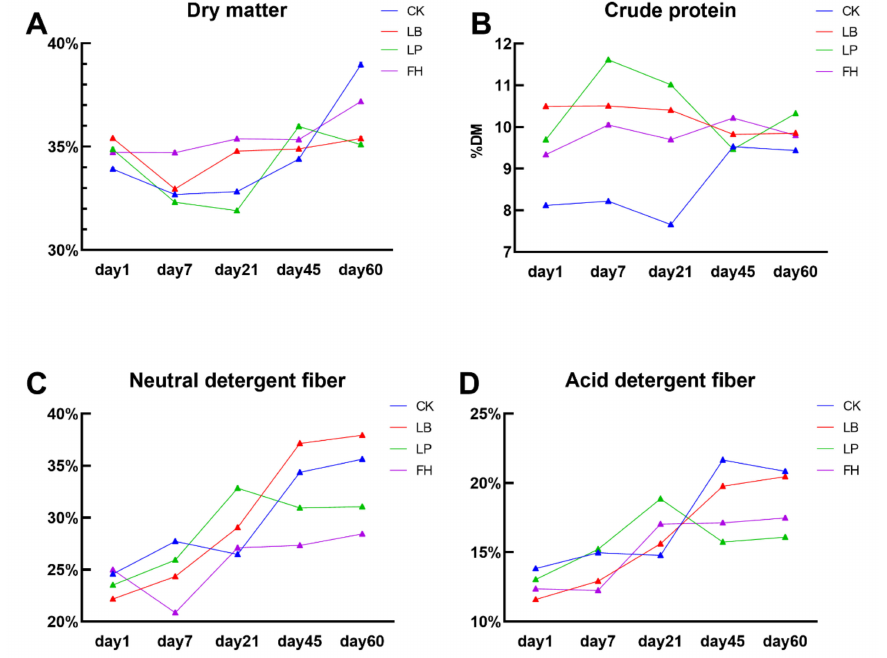
Figure 2. Changes in the chemical composition of M. aquaticum silage during ensiling. ( A ) Dry matter content; ( B ) crude protein content; ( C ) neutral detergent fiber content; and ( D ) acid detergent fiber content. CK, control; LB, Lactobacillus buchneri ; LP, Lactobacillus plantarum ; and FH, combination of LB and LP.